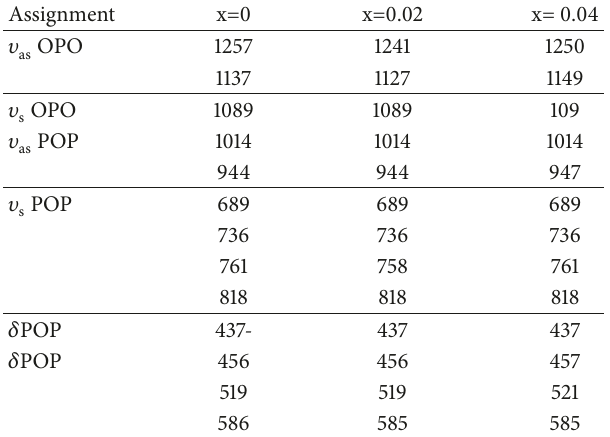
Figure 7: The magnetic susceptibility ( 𝜒 ) and inverse magnetic susceptibility ( 1/𝜒 ) measurements as a function of temperature of LiGd(PO 3 ) 4